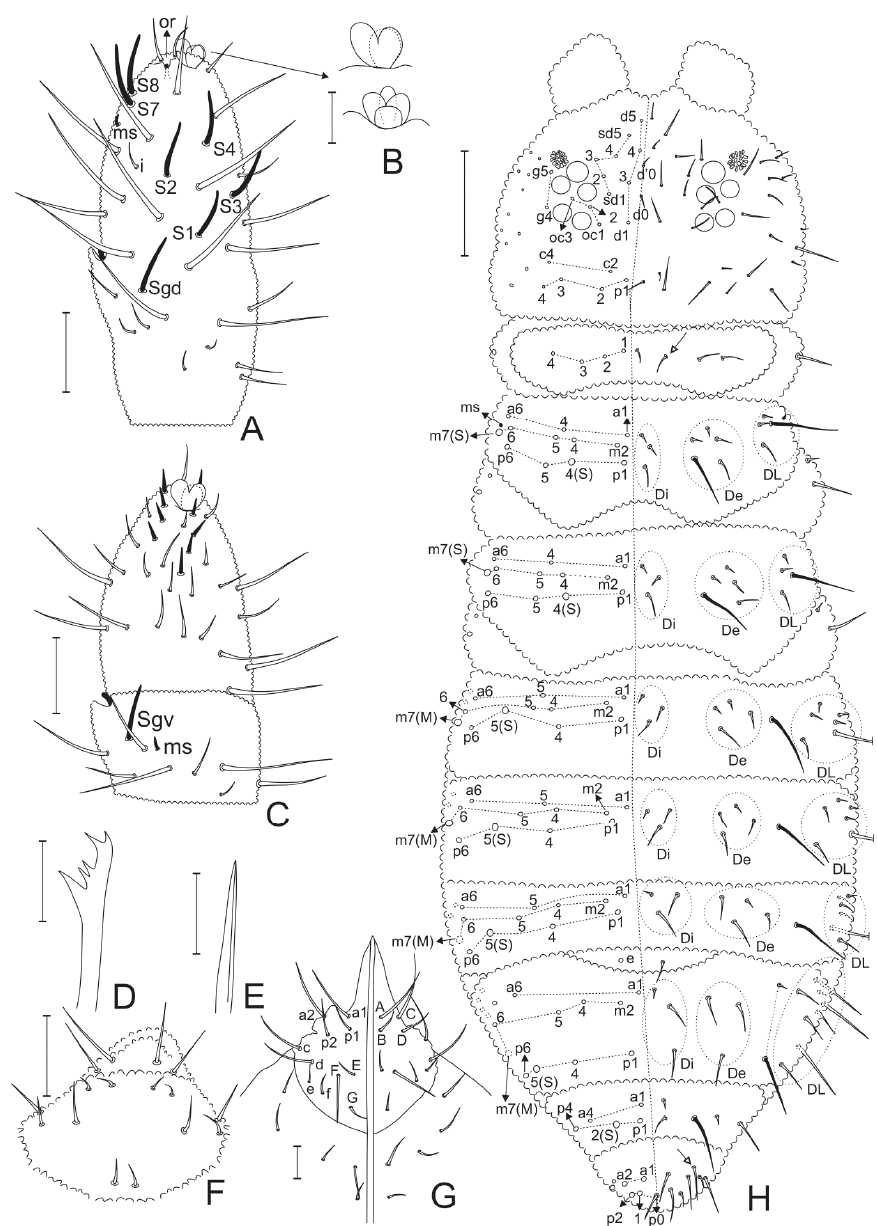
Figure 2. Neotropiella arretada sp. nov.: ( A ) left Ant. IV–III, dorsal view; ( B ) detail of different morphologies of Ant. IV apical bulb; ( C ) left Ant. III–IV, ventral view; ( D ) right mandible apex; ( E ) right maxilla capitulum; ( F ) clypeus and labrum morphology; ( G ) labial and postlabial chaetotaxy, left follows [28] and right [3] labial nomenclatures; ( H ) body dorsal chaetotaxy, S = long sensilla, M = macrochaetae (white arrows point to chaetae present or absent). Scale bars: 5 μ m ( D,E ); 10 μ m ( B ); 20 μ m ( A,C,F–G ); 100 μ m ( H ).